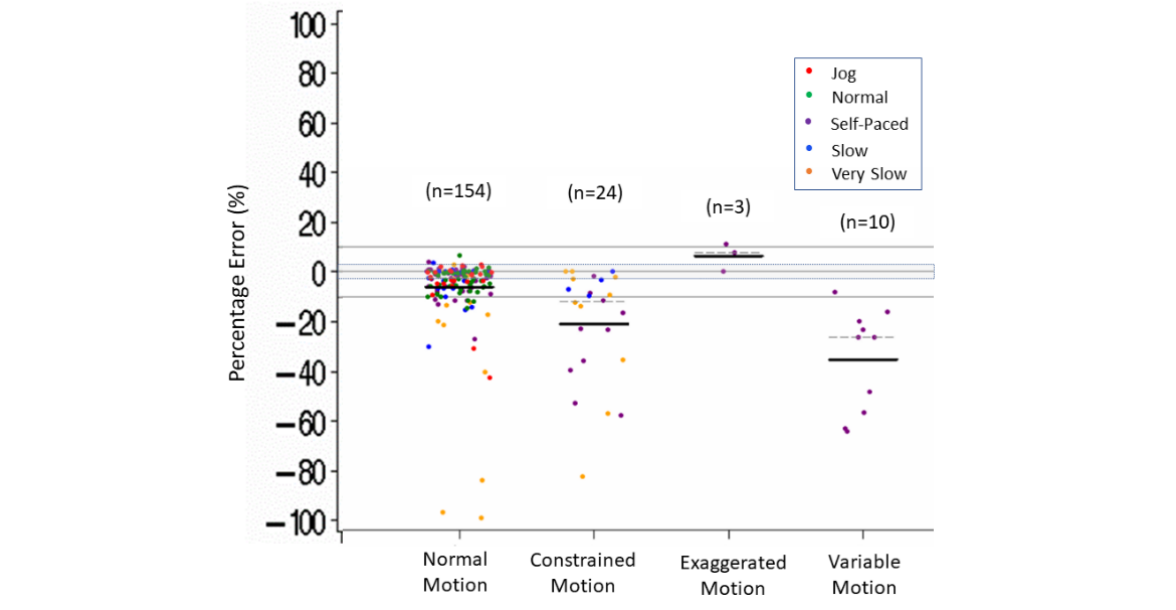
Figure 5. Step count percentage error in controlled settings. Body motion (normal, constrained, exaggerated, variable) by speed (jog, normal, self-paced, slow, very slow). Dark lines indicate mean (horizontal). Dashed lines indicate median